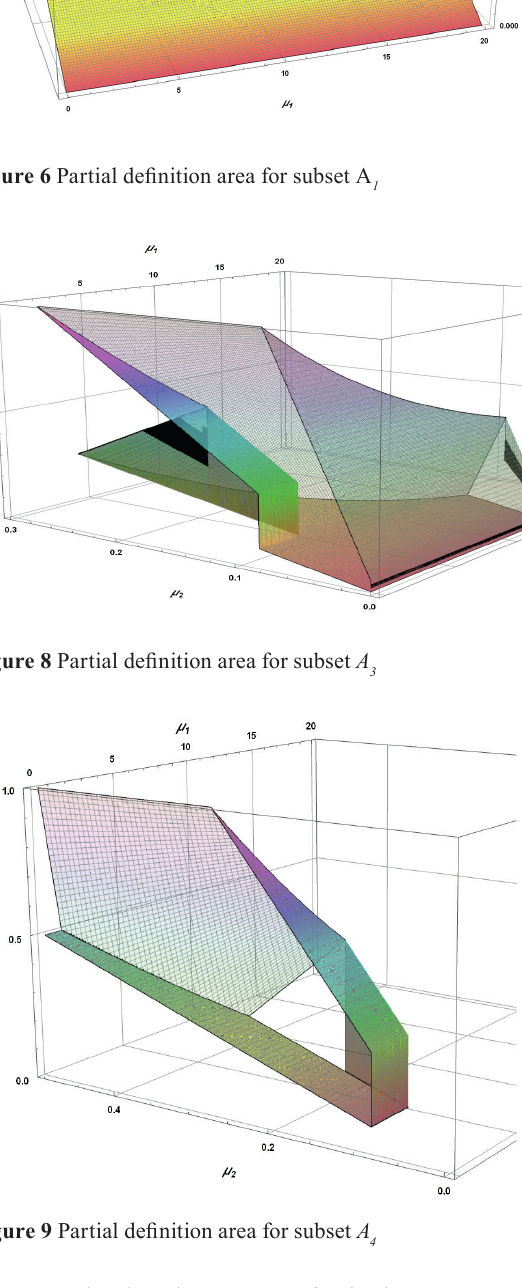
Figure 9 Partial definition area for subset A